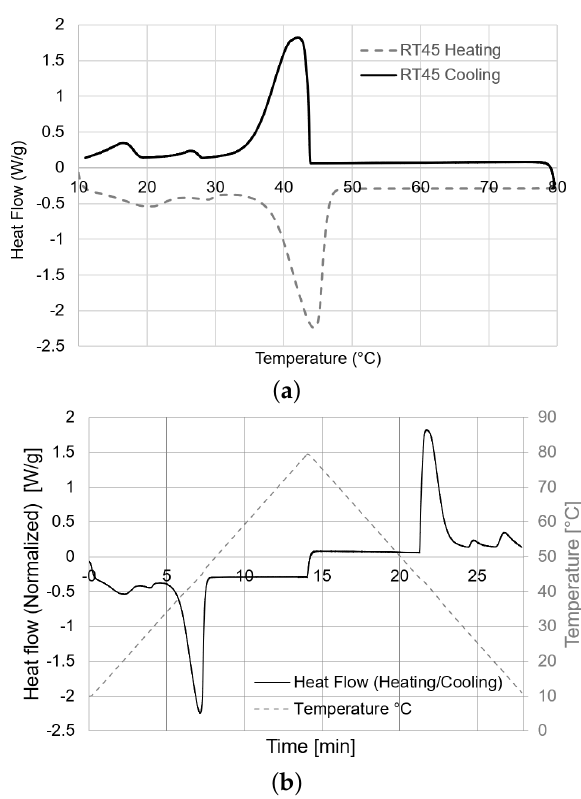
Figure 12. ( a ) Differential scanning calorimetry (DSC) curve; ( b ) Typical DSC response when performing a dynamic mode, heating and cooling.